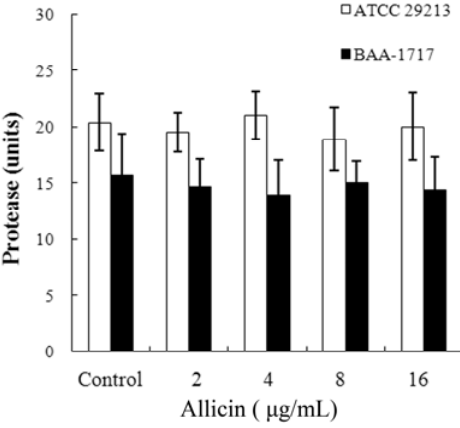
Figure 3. Protease units of S. aureus culture supernatants after treatment with allicin. Values represent the mean ± SD for three independent experiments.